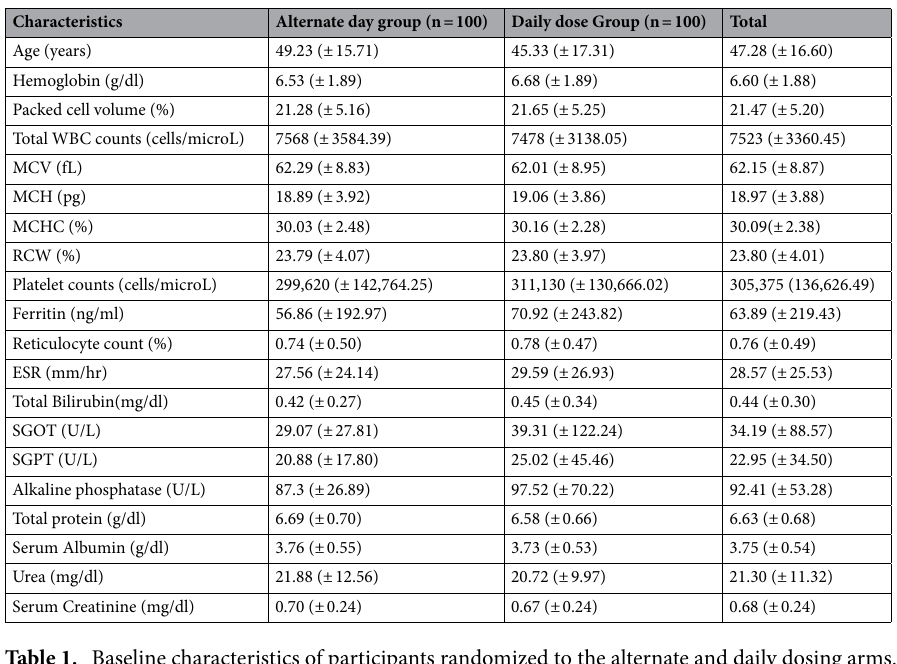
Table 1. Baseline characteristics of participants randomized to the alternate and daily dosing arms.